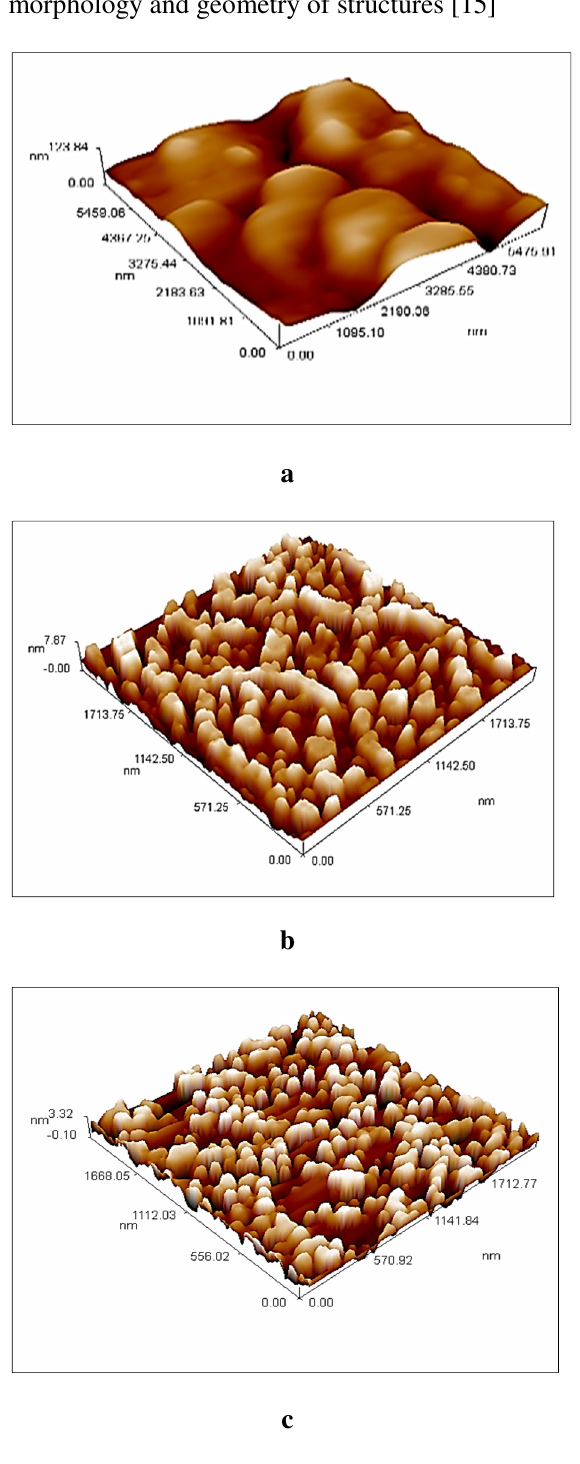
Fig. 4. The AFM results of cement mortar: (a) Mortar without addition, (b) Mortar with 0.25 TiO 2 , and (c) Mortar with 1% TiO 2 .